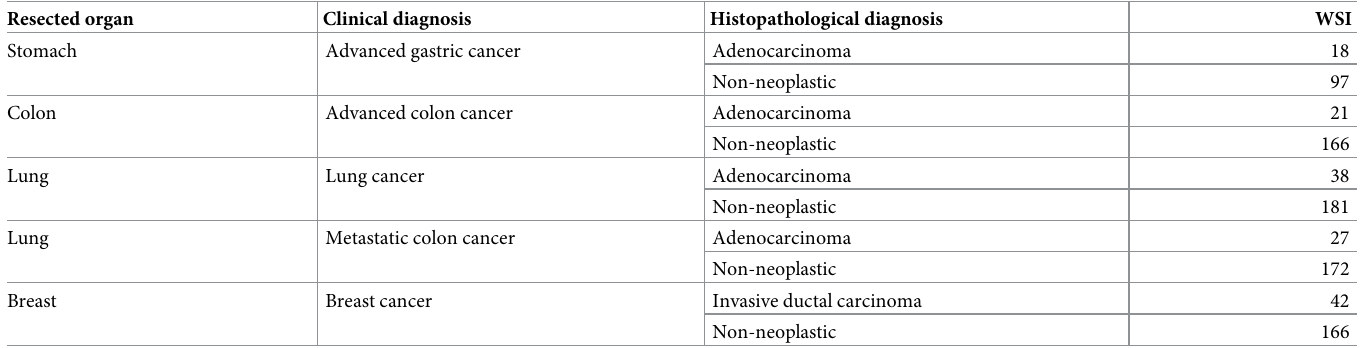
Table 4. Distribution of whole slide images (WSIs) in the lymph nodes test